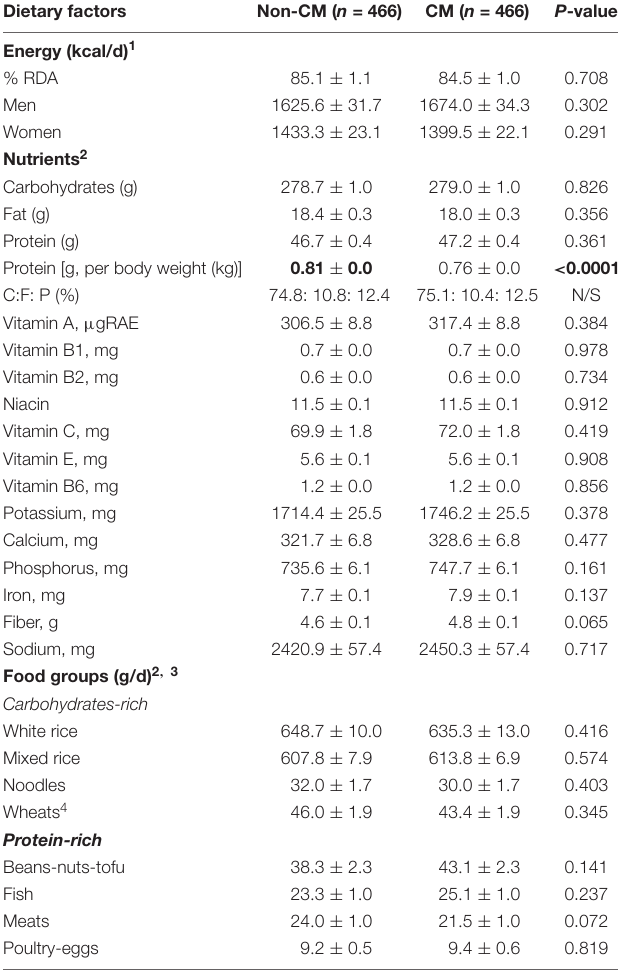
TABLE 2 | Daily energy and nutrients intakes and food groups of the participants according to their CM pattern. Dietary